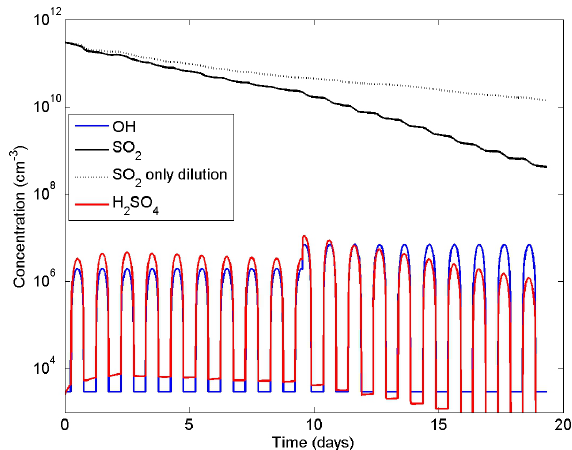
Fig. 9. Time sequences of the modeled molecular number concen- trations of OH, SO 2 and gas-phase H 2 SO 4 . Also given is a curve representing an inert plume dilution tracer having the same initial concentration as SO 2 (SO 2 only dilution).